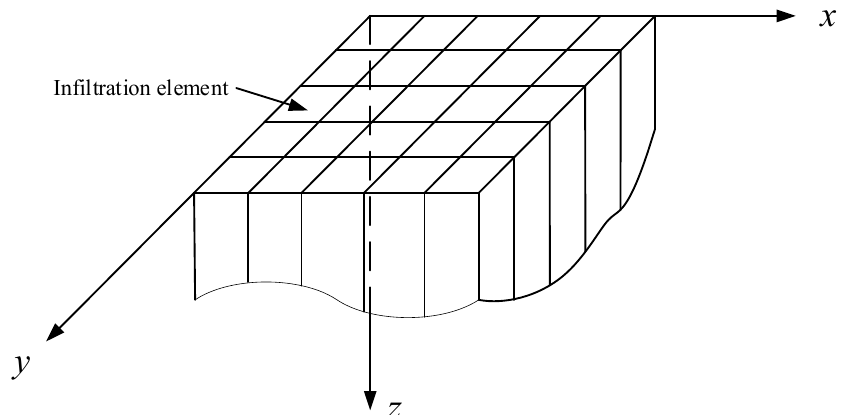
Figure 1. Schematic diagram of rectangular cube infiltration elements.